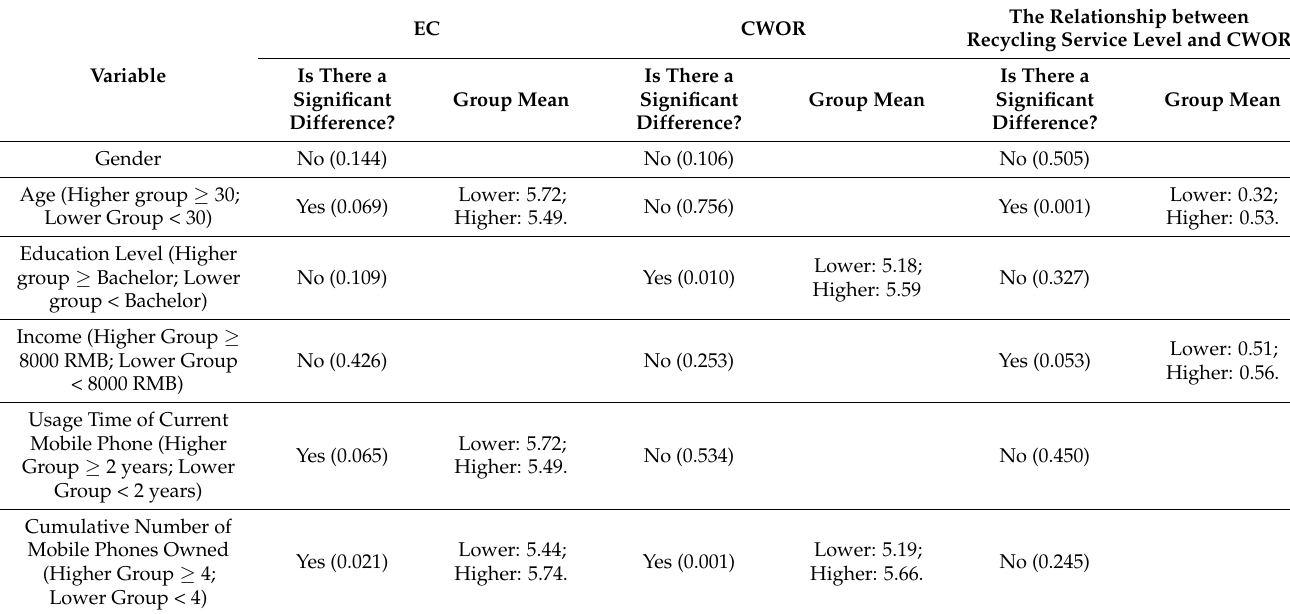
Table 6. Results of AMOS multi-group